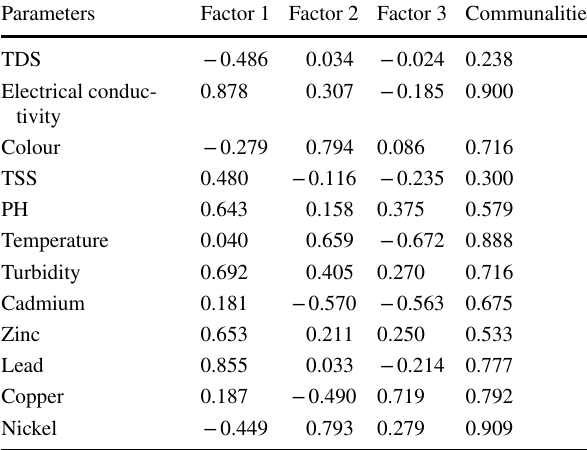
Table 5 Factor analysis for the wet